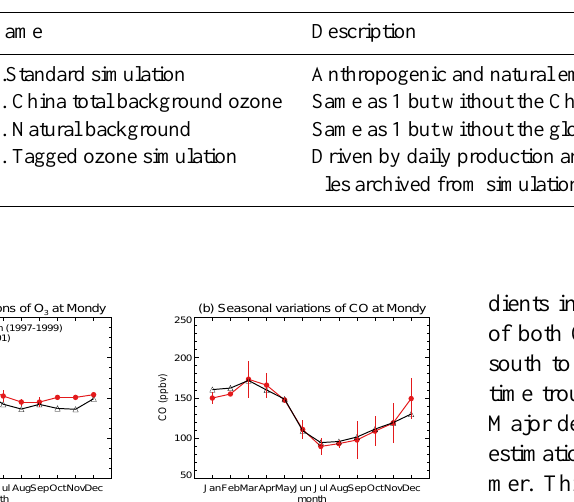
Table 1. Simulation used in the study.